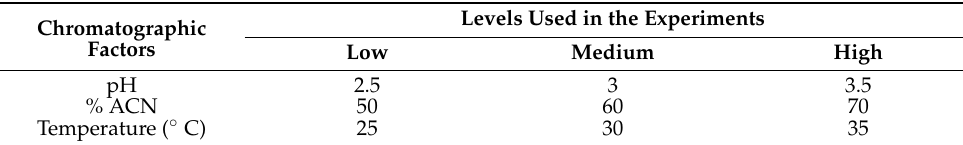
Figure 2. Ishikawa diagram showing the factors and parameters (boldface) affecting the HPLC separation. Table 1. The selected factors and their levels.